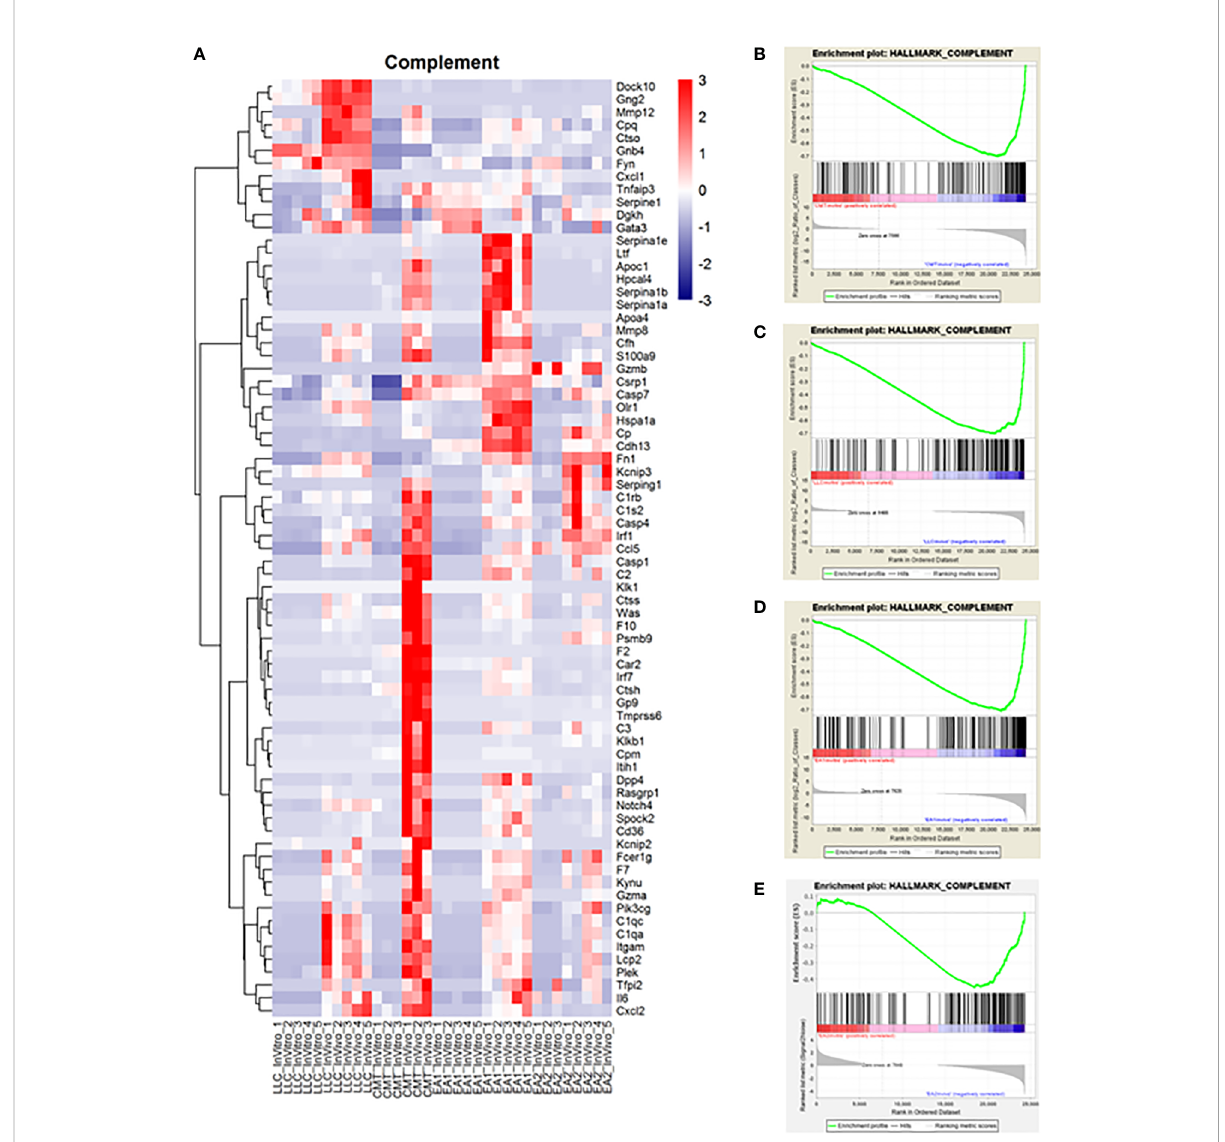
FIGURE 3 Complement proteins induced in vivo in murine NSCLC tumors and complement genes were found to be upregulated in vivo compared to in vitro cells. Gene Set Enrichment Analysis was performed on the data set to analyze changes in the complement pathway in vivo versus in vitro . (A) A heat map showing the upregulation of complement pathway genes in vivo . Enrichment plots for the complement pathway in CMT cells (B) , LLC cells (C) , EA1 cells (D) , and EA2 cells (E) . The “ HALLMARK_COMPLEMENT ” gene set from the Hallmark Gene Sets for this GSEA. The enrichment plots show the in vitro changes that positively correlate with complement genes on the left side of the plot in red while the in vivo changes negatively correlated with complement genes are on the right side in